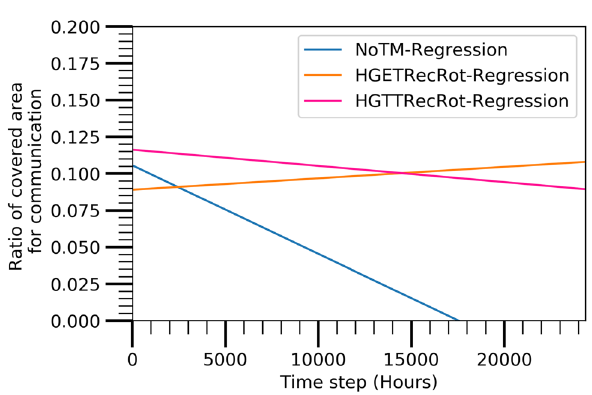
Figure 13. Covered communication area based on prediction